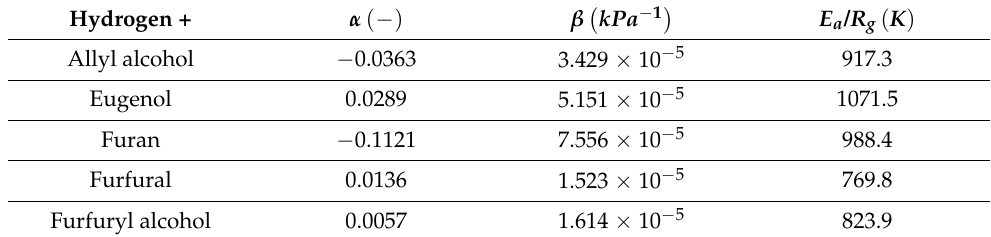
Table 2. Coefficients of the proposed model for correlating hydrogen solubility in biochemicals.